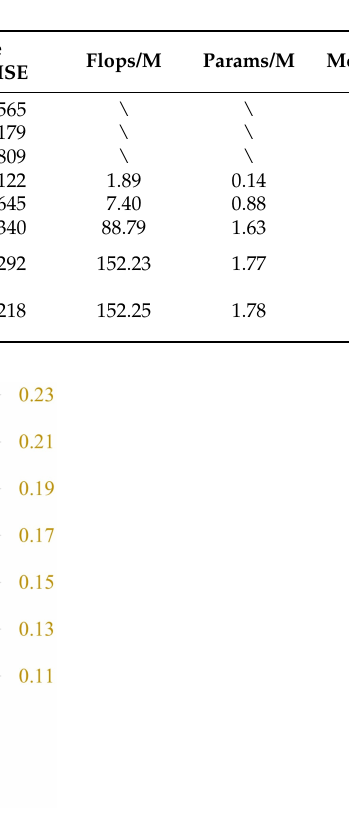
Table 7. The comparisons between the proposed methods and the other advanced algorithms based on inter-well data.